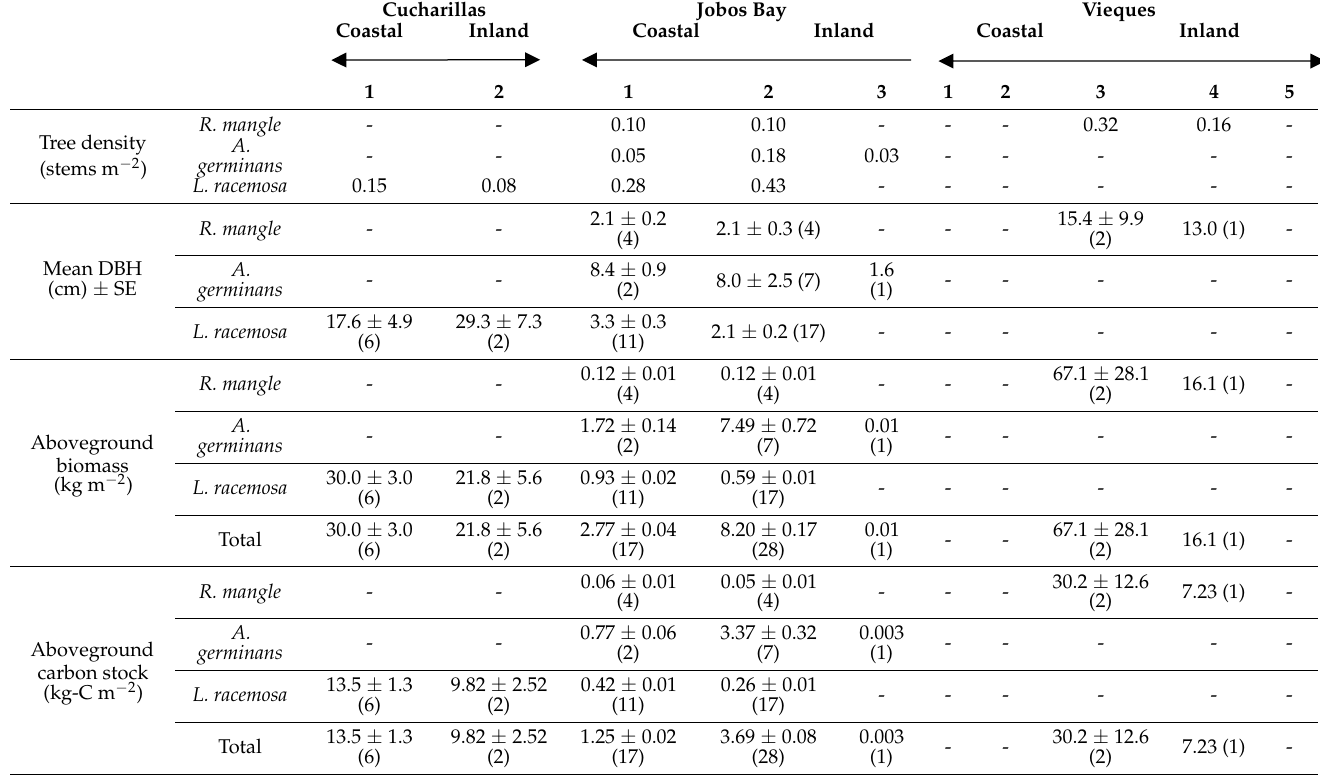
Table 1. Mangrove stem density and diameter at breast height (DBH), estimated aboveground biomass, and estimated aboveground carbon stock of mangrove species and communities from Cucharillas, Jobos Bay, and Vieques sites in Puerto Rico. Each sample site is numbered where lower numbers are sites closest to the coast and higher numbers are the most inland sites. Values are averages ± standard deviation (number of samples).